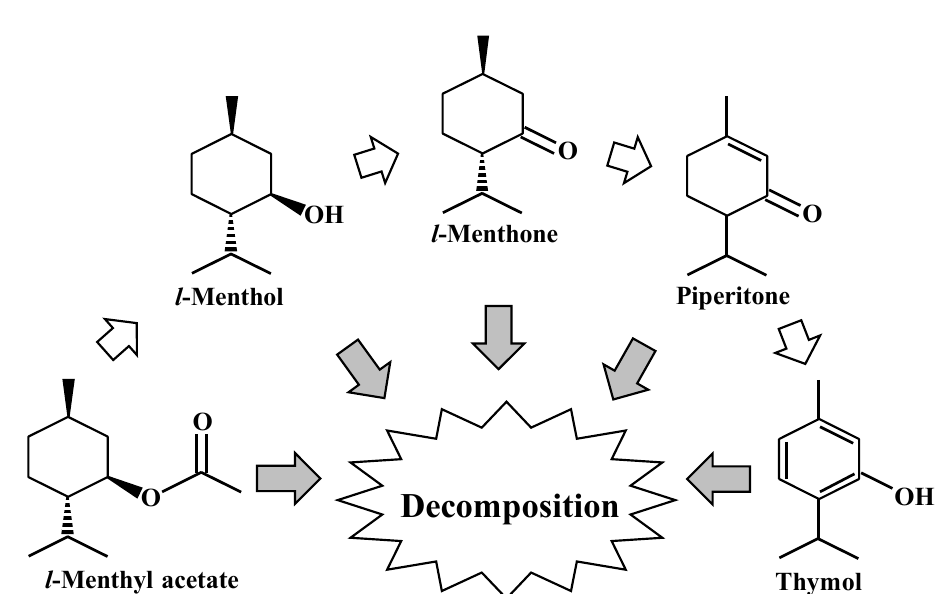
Figure 6. Schematic chart of conversion and hydrothermal decomposition of major components of mint essential oil during subcritical water treatment.